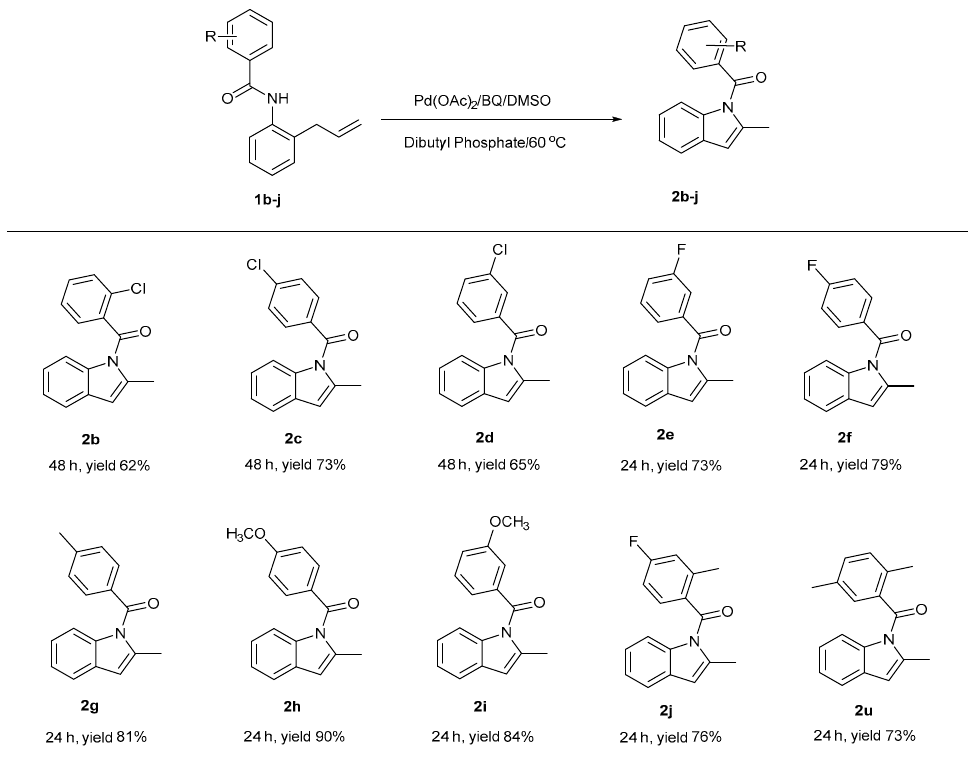
Table 2. Substrate scope of substrates with substituents at the positions (R). a,b. Conditions: See Supplementary Materials for details.